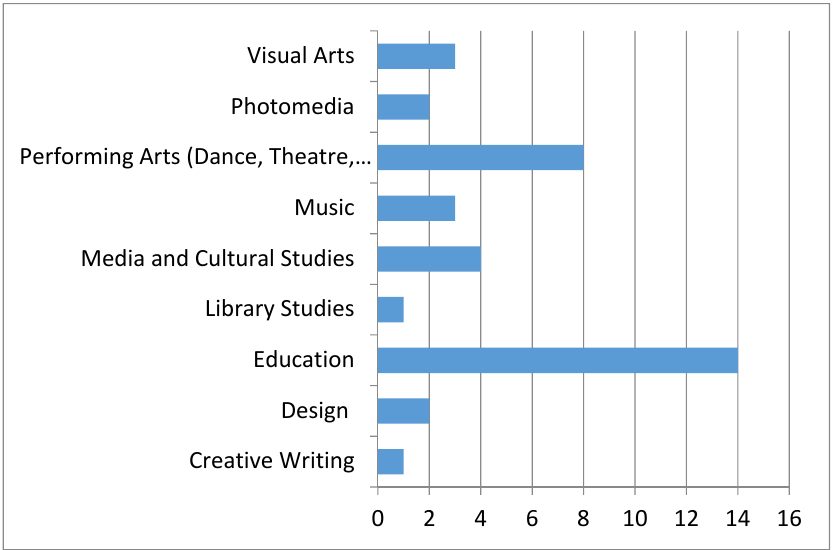
Figure 5. Disciplinary Backgrounds of Respondents.